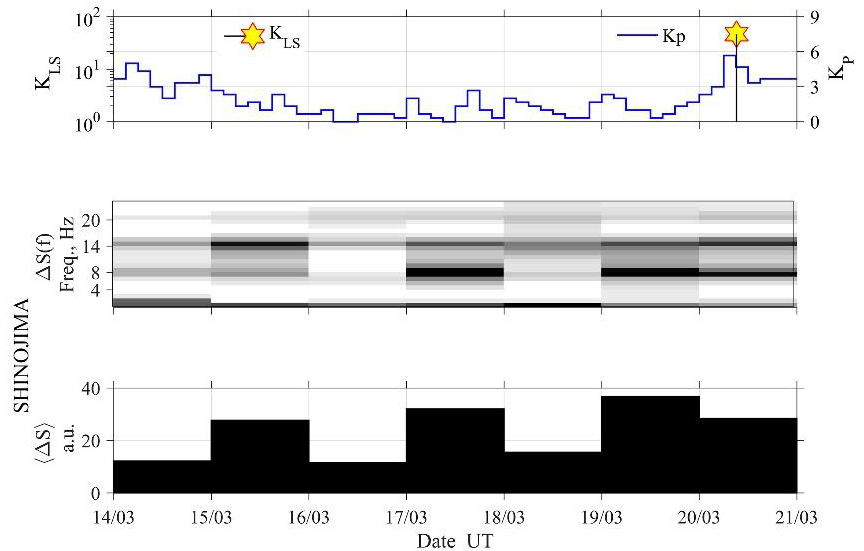
Figure 5. The evolution of seismicity, geomagnetic activity, and parameter of ULF/ELF magnetic field radiation over the interval of 14–20 March 2021 for the second EQ. The top panel shows evolutions of seismicity K LS and geomagnetic activity Kp. The next two panels display ∆ S spectra and their daily maximum values observed in SHI.